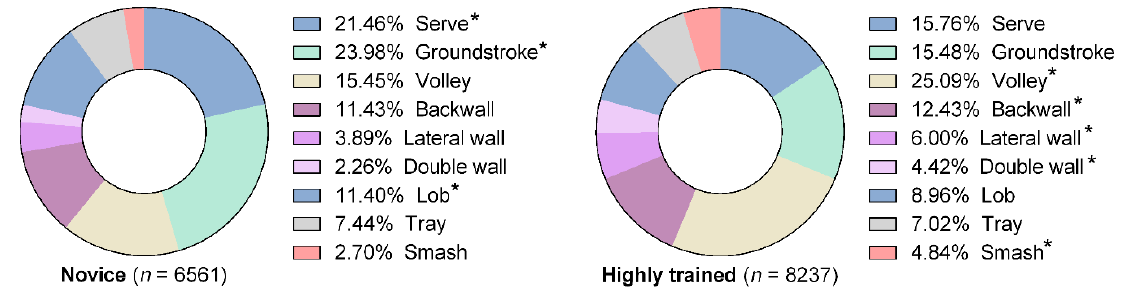
Figure 2. Stroke type distribution between highly trained and novice padel players. Asterisks indicated a significantly greater prevalence in a given group compared to the other ( p < 0.05).